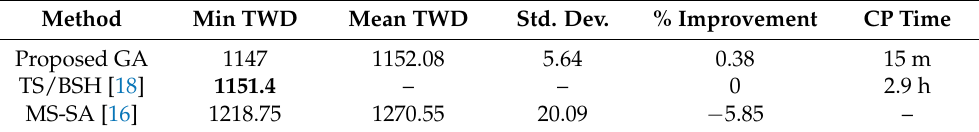
Table 5. Summary of results for test problem P20.